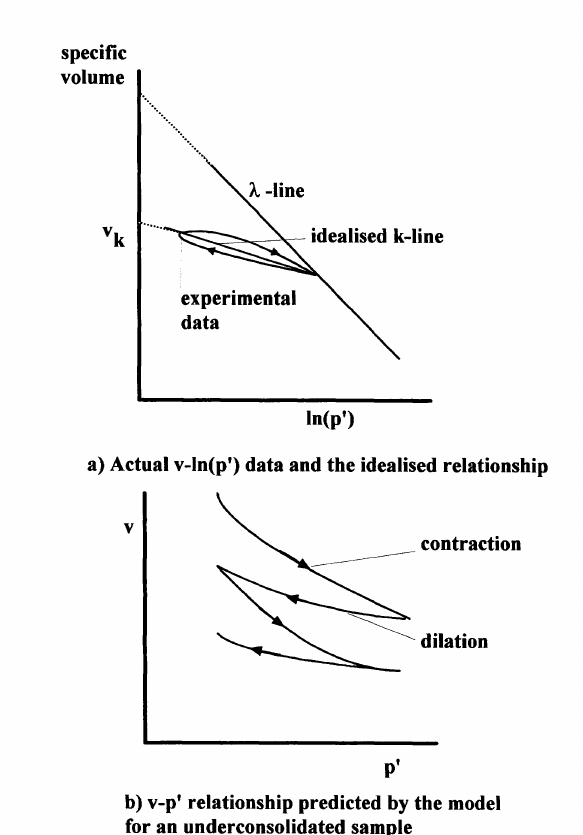
FIGURE 6 v versus In(p') relationships: (a) showing hysteresis effects and (b) as predicted by the applica tion of the model in the